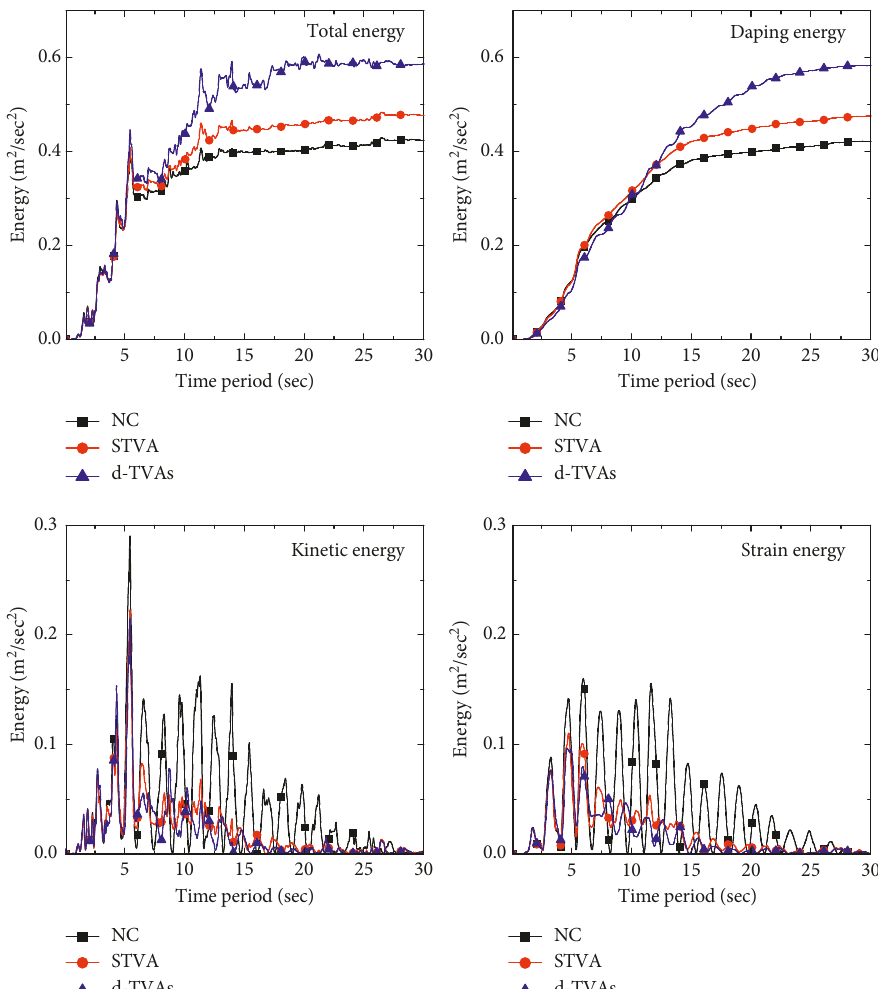
Figure 4: Different energies for the NC, STVA, and d-TVAs subject to Imperial Valley, 1940, ground